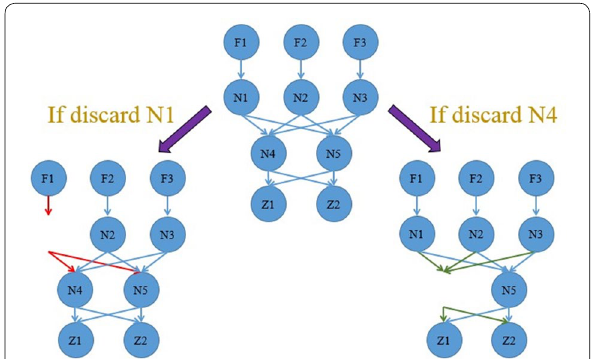
Fig. 1 An example network illustrating the concept of middleman power (MP) and its superiority over betweenness centrality (BC) under certain